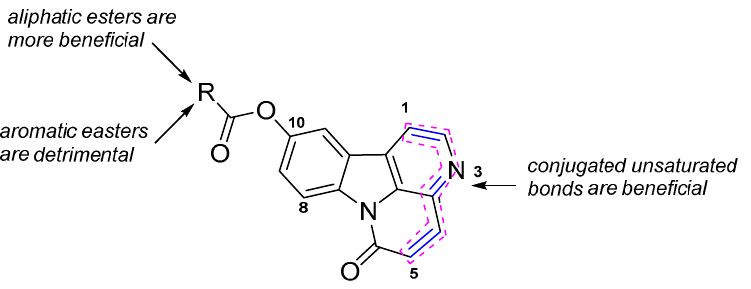
Figure 3. Structure-activity relationship for the antibacterial activity.